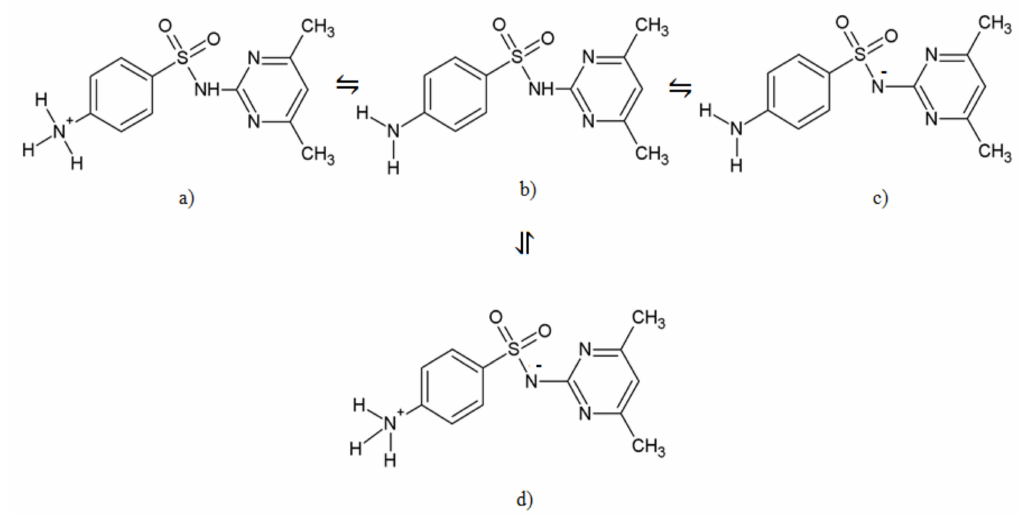
Figure 2. SMT forms: ( a ) Cationic; ( b ) nonionic; ( c ) anionic, and ( d )